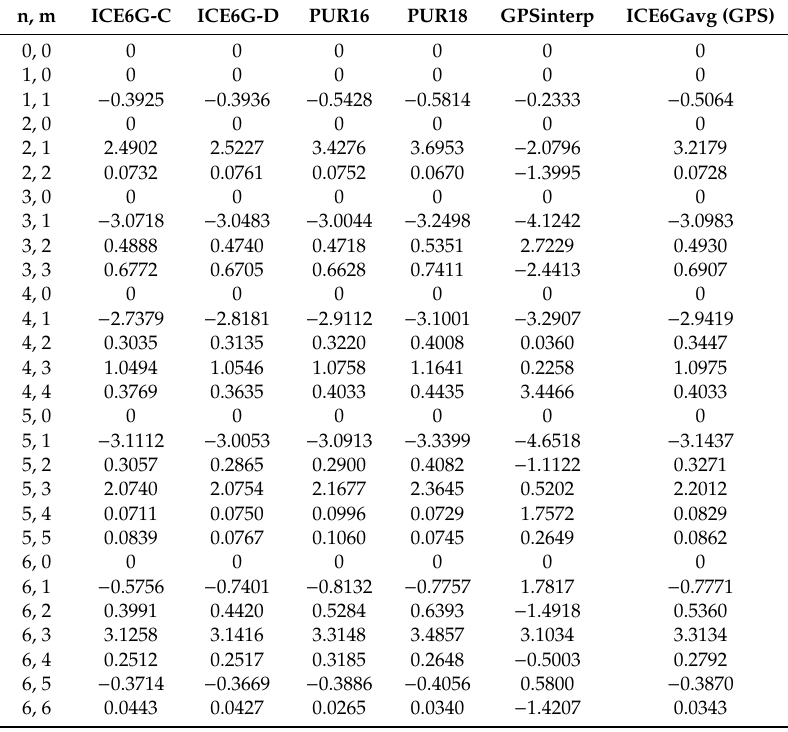
. s X nm of the uplift rates (Unit: 10 − 11 yr − 1 ) 1